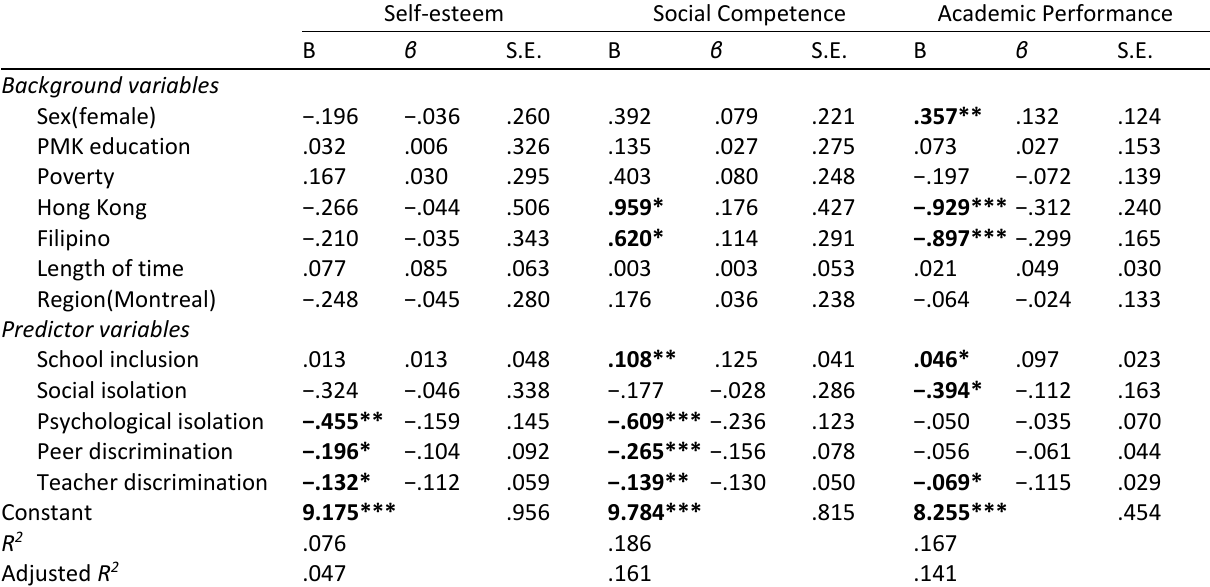
Table 4. Regressions of psychosocial functioning and academic performance on predictor